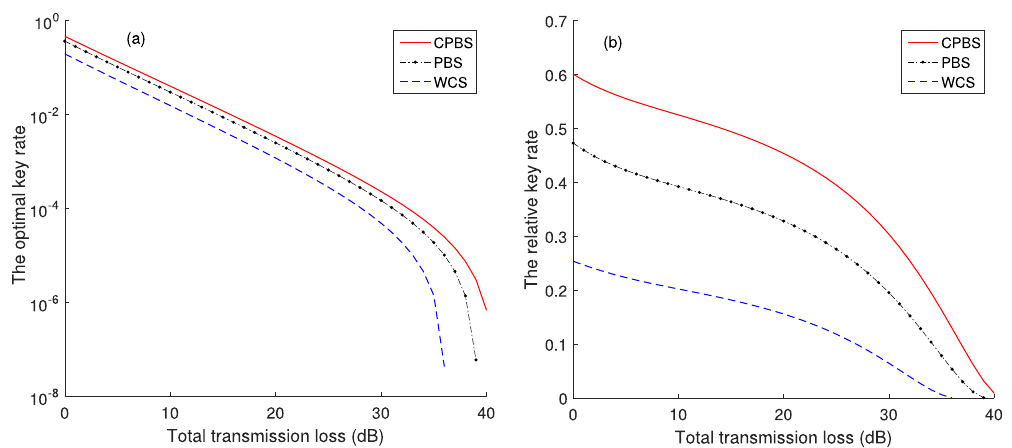
Figure 7. ( a ) Optimal key rates of decoy state BB84 protocol with statistical fluctuation: cascaded photon- blockade source (CPBS), the photon-blockade source without a cascade (PBS) 19 and the WCS using three different intensities (0, 0.2 and 0.5). ( b ) The relative value of the key rates between chosen sources and the perfect single-photon source (PSPS). The data size N = 10 9